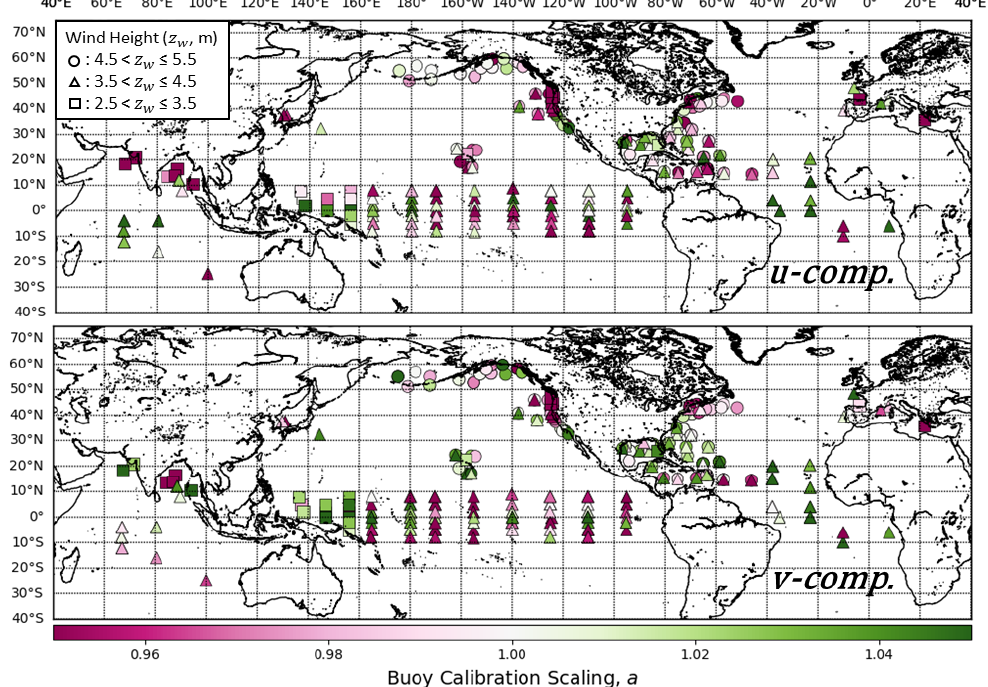
Figure 5. Triple collocation calibration scalings ( a ) of buoy U 10 S components calibrated with ASCAT winds as the standard for the full range of winds at the individual buoy level. The top subplot shows the calibration scalings for the u -component ( a ubuoy ) and the bottom is the v -component scalings ( a vbuoy ). Point shapes correspond to the buoy anemometer height ranges shown in the leg ‐ end.